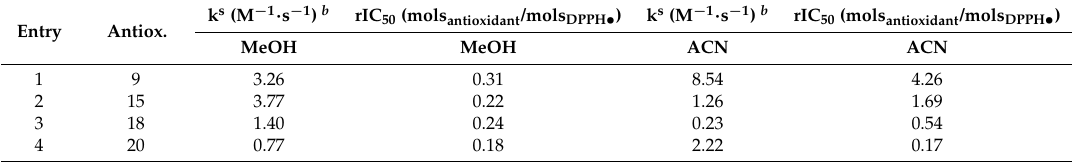
Table 5. Bimolecular rate constants (M − 1 · s − 1 ) for H-atom abstraction from compounds 9 , 15 , 18 , and 20 by DPPH • a